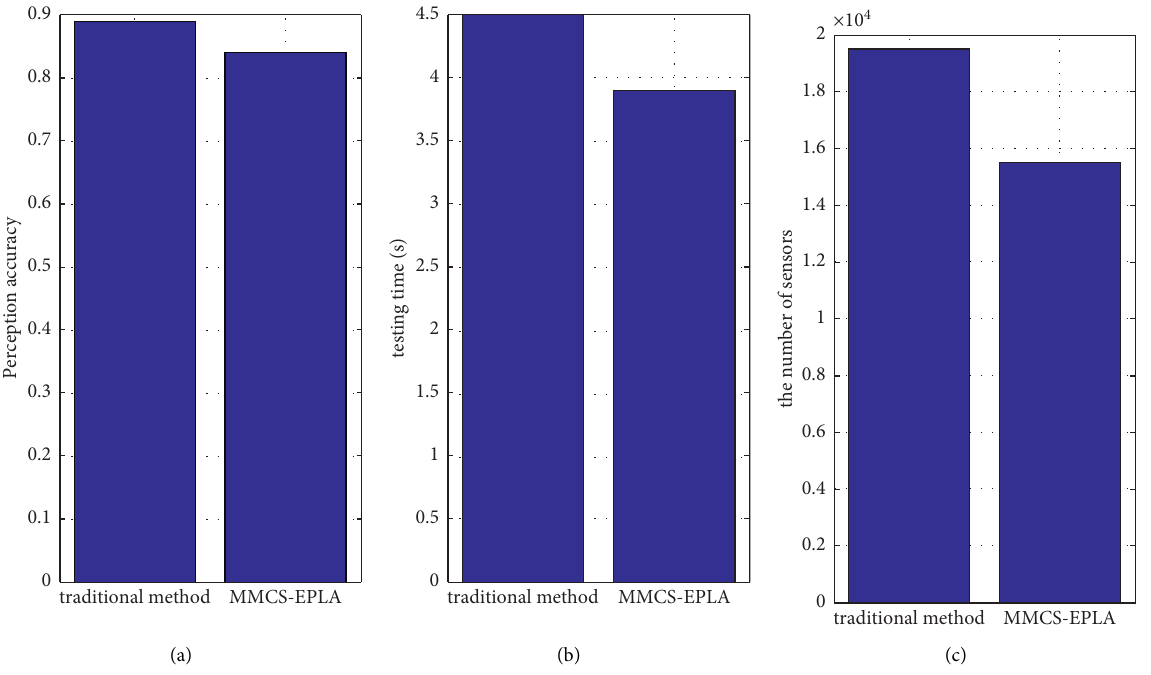
Figure 7: Performance comparison between MMCS-EPLA and traditional method in the PAMAP2 data